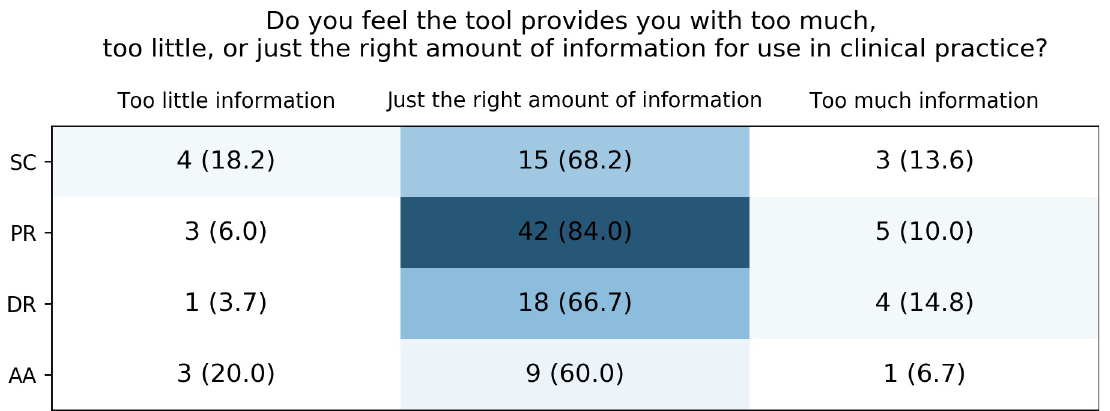
Fig 8. Healthcare providers’ perception of the information amount of the different CDS tools. SC: Safety Code cards, PR: printed reports, DR: digital reports, AA: automatic alerts.